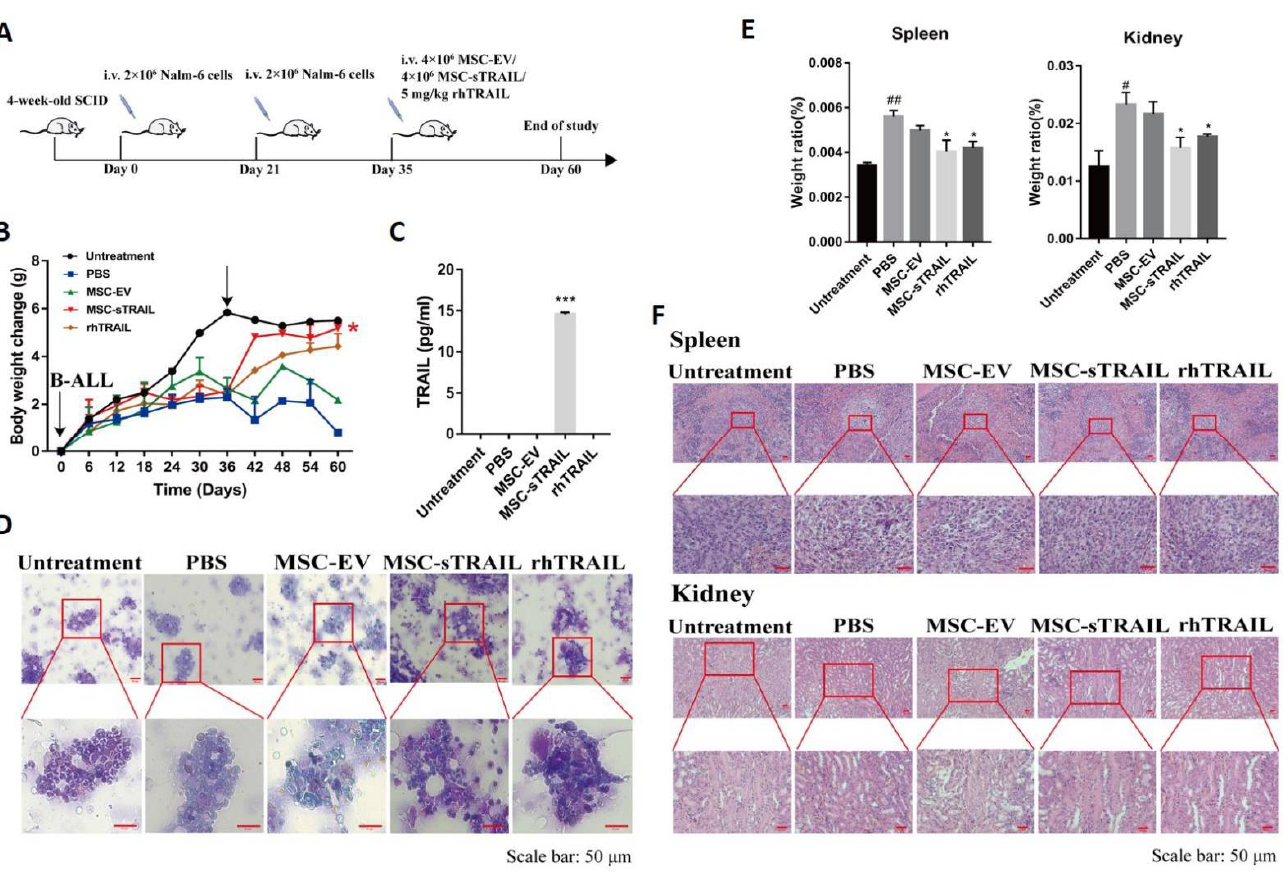
Figure 4. MSC-sTRAIL treats B-ALL-induced injury in mice. SCID mice were treated with 2 × 10 6 Nalm-6 cells on day 0 and day 21, then on day 35, mice of untreated group, PBS group, MSC-EV group, MSC-sTRAIL group, and rhTRAIL group were each injected with 200 µ L PBS, 200 µ L PBS, 2 × 10 6 MSC-EV cells, 2 × 10 6 MSC, 5 mg/kg rhTRAIL, respectively. ( A ) in vivo experiment design. ( B ) MSC-sTRAIL inhibits B-ALL-induced weight loss in mice. ( C ) Serum TRAIL levels detected by ELISA. ( D ) Wright Giemsa staining of mouse bone marrow. ( E ) MSC-sTRAIL inhibits B-ALL-induced increase in specific gravity of spleen and kidney in mice. ( F ) H&E staining (Scale bar 50 µ m. n = 5 per group; Student’s t test, *, p < 0.05, ***, p < 0.001, MSC-EV group and MSC-sTRAIL group compared with PBS group; #, p < 0.05, ##, p < 0.01, PBS group compared with untreated group. Untreated group: SCID mice not inoculated with Nalm-6